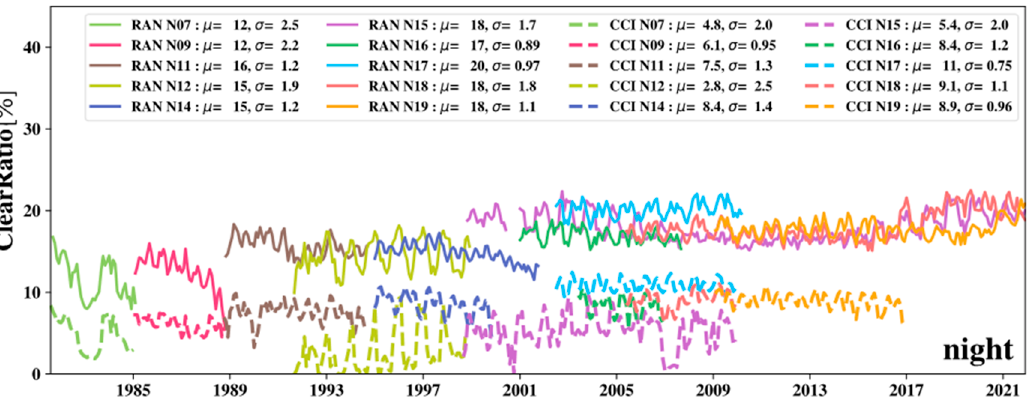
Figure 8. Time series of monthly nighttime Clear-Sky Ratios (CSRs) in RAN2 and CCI L2P prod- ucts. (Data are from the NOAA SQUAM system [21,22]).